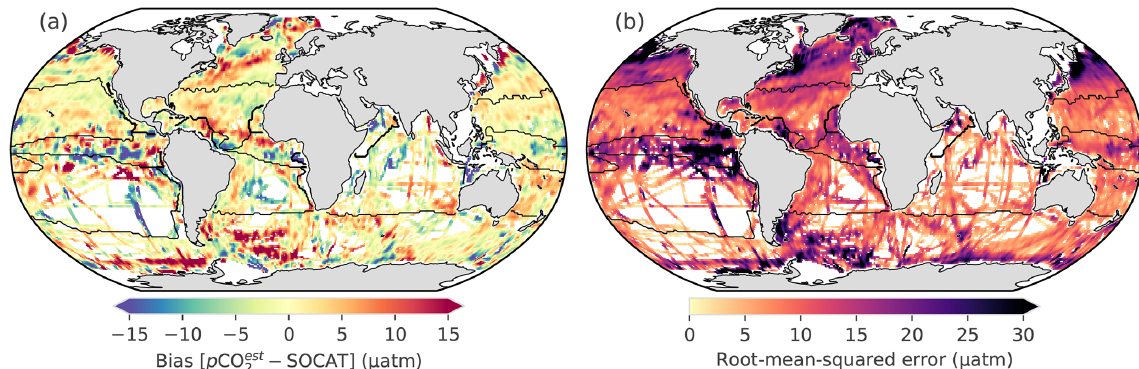
Figure 7. Panel (a) shows the biases from the robust test estimates; panel (b) shows the RMSEs for CSIR-ML6. Convolution has been applied to panels (a) and (b) to make it easier to see the regional nature of the biases and RMSE. Figure S8 shows the bias for every ensemble member. Black lines show the regions as defined in Fig.